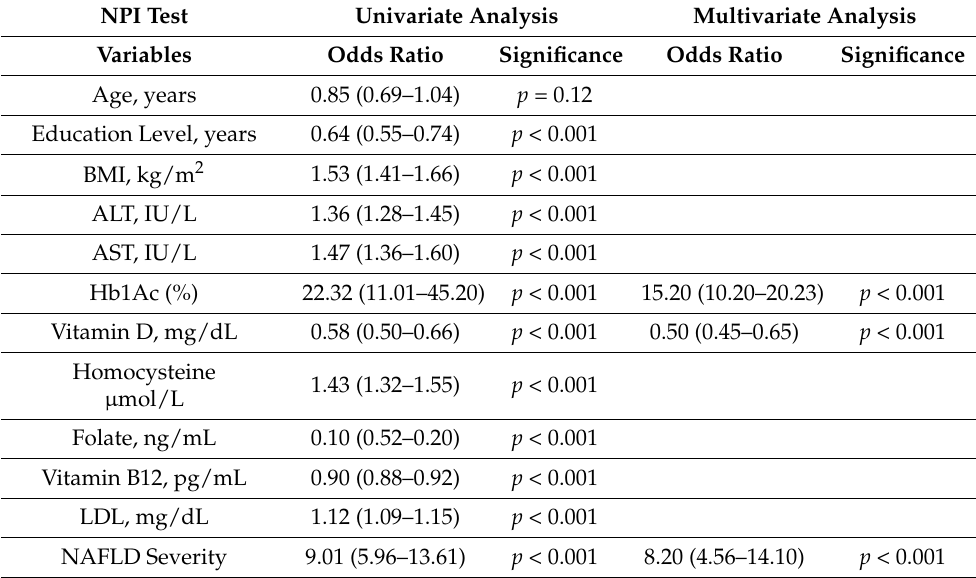
Table 8. Factors associated with worse NPI test results in terms of Odds Ratio and its 95% C.I. Variables are initially studied univariately and then multivariately by choosing the model with the lowest